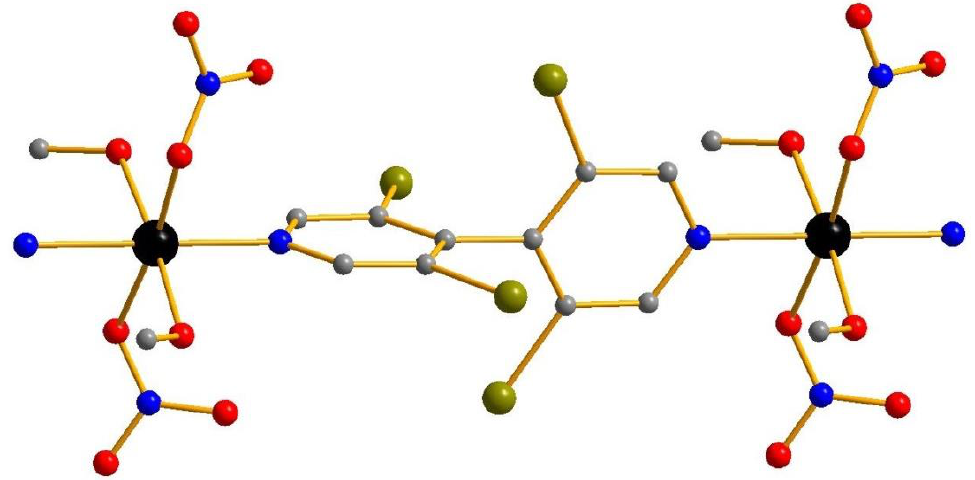
Figure 5. Fragment of the structure of 2 . H atoms are omitted from clarity; only N atoms of side Brbipy ligands are shown. Co black, O red.